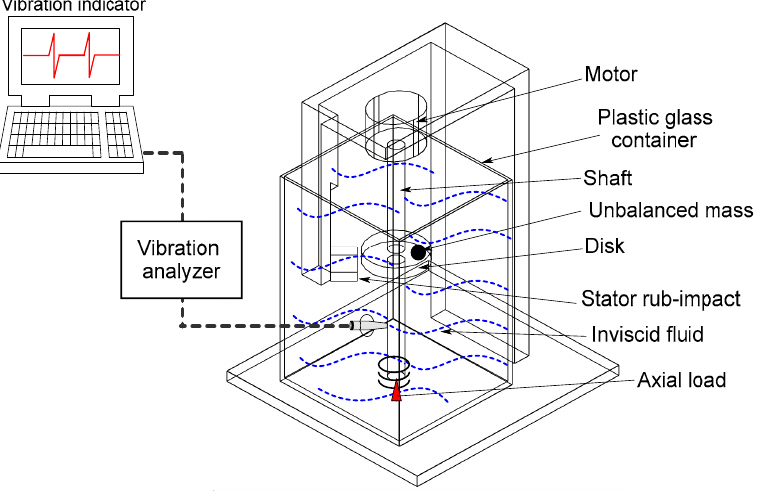
Figure 1. Line diagram of idealized vertical rotor-to-stator system submerged in an inviscid fluid. The Bently Nevada Rotor Kit RK4 was used to build and outfit the experiment. The system is likely instrumented with sensors to measure various parameters such as whirl orbits, shaft deflection, and fluctuation frequency during passage through critical speeds.